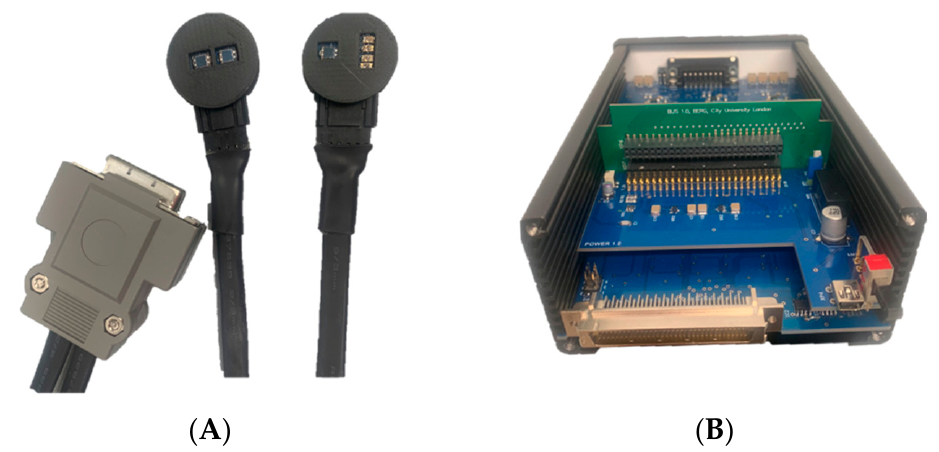
Figure 6. ( A ) Probe prototype with its 4 LEDs, 3 photodiodes and 15D connector. ( B ) Open ZenTBI view of the instrumentation system.